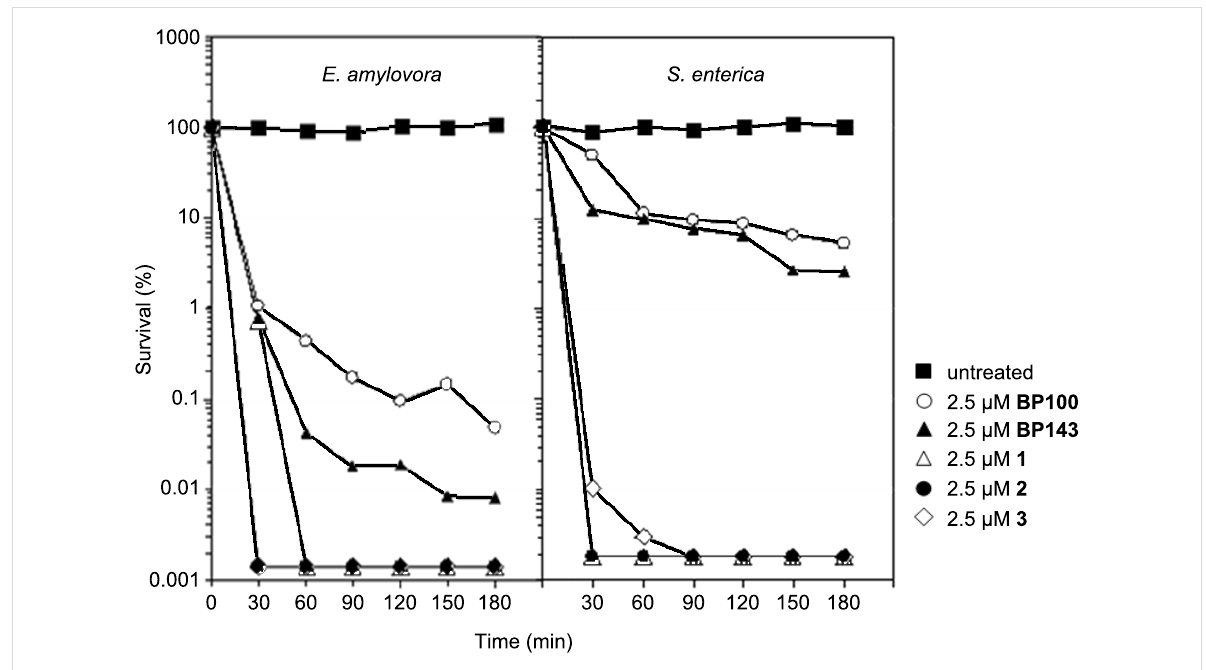
Figure 2: Kinetics of bactericidal activity on E. amylovora and S. enterica in the presence of peptides and carbopeptides. Viable cells were deter- mined at different time intervals.